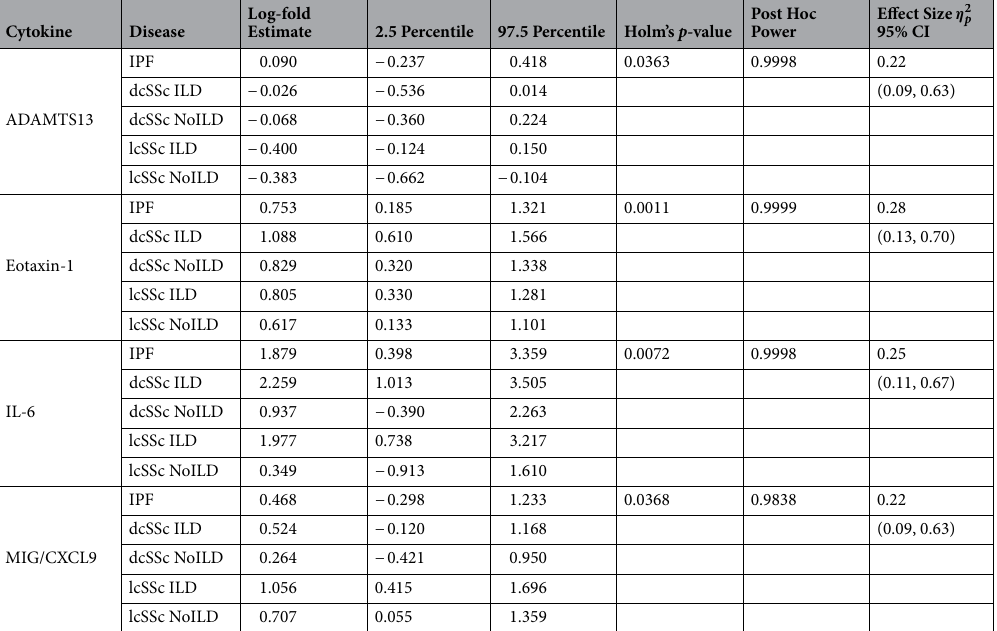
Table 2. Log-fold changes in cytokine levels by disease group compared to control. Estimates, confidence limits, Holm’s p -value, and effect size with bootstrapped 95% confidence interval (CI) are from a multiple regression linear model using R software of the base-2 logarithm of each cytokine level from peripheral blood for differences among categories with: continuous covariates of age and disease duration; categorical covariates of ever smoking, sex, antifibrotic medication (nintedanib or pirfenidone), anti-autoimmune medication (azathioprine, cyclophosphamide, mycophenolate mofetil, or rituximab); and interaction between age and sex. The post hoc power for a test at the 5% level of significance was estimated using PASS software in an analysis- of-covariance model with 7 covariates with group log-folds, proportion of variance explained by the multiple regression model, and residual error as estimated by R